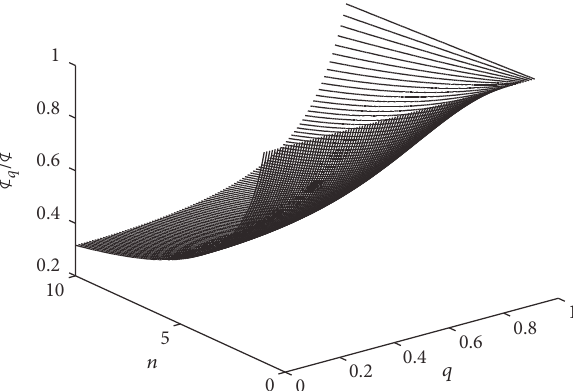
Figure 8: q -deformed scalar field for various values of 𝑛 and 𝑞 , in terms of standard scalar field.